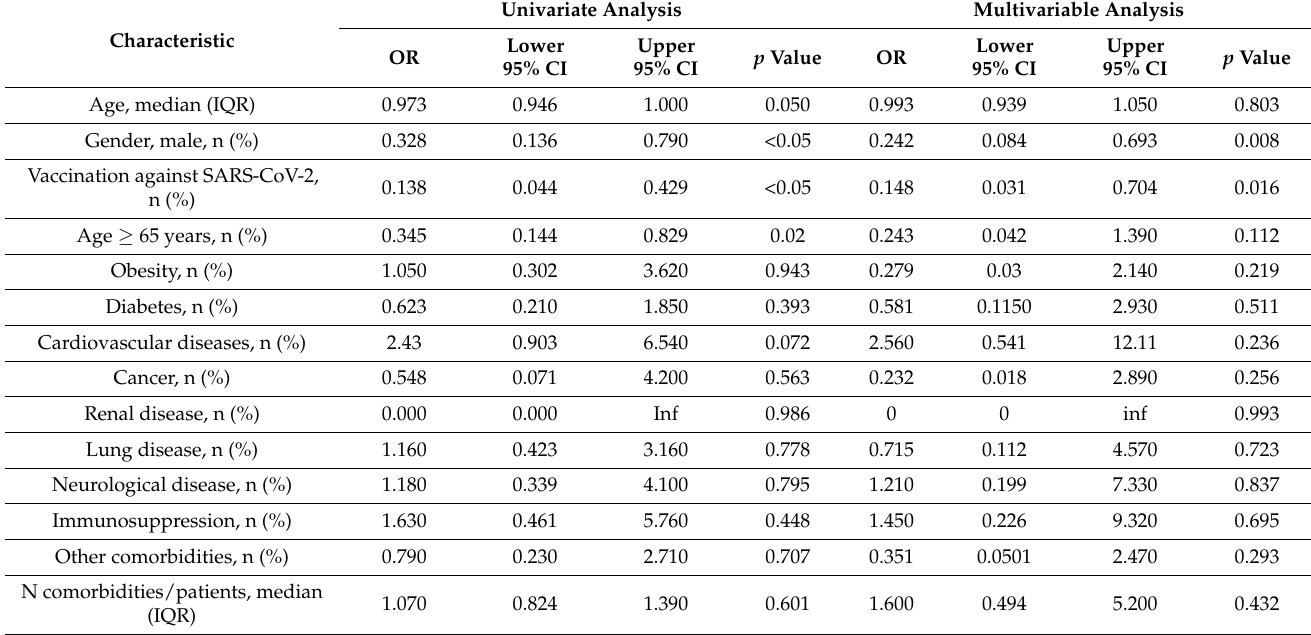
Table 3. Univariate and multivariable analysis for factors associated with AEs in patients who received